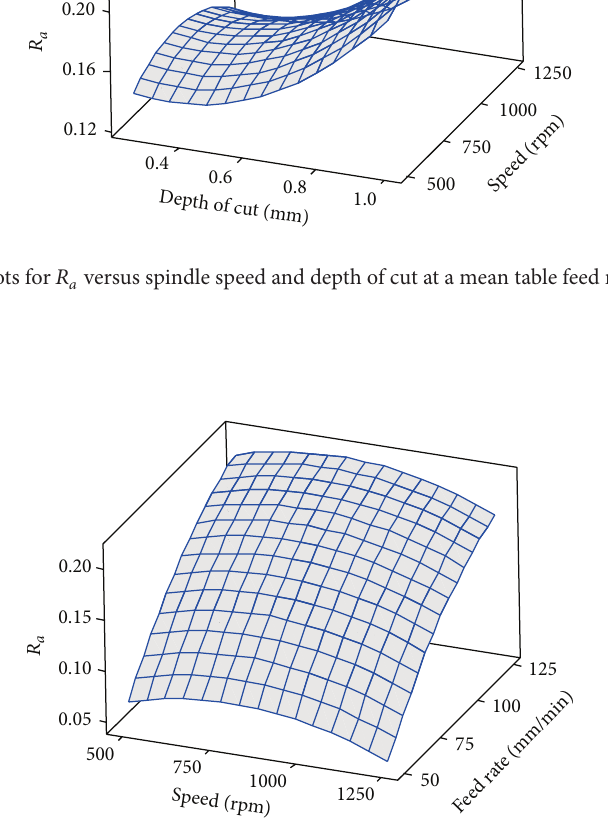
Figure 9: Surface plots for 𝑅 𝑎 versus spindle speed and table feed rate at mean depth of cut of 0.625